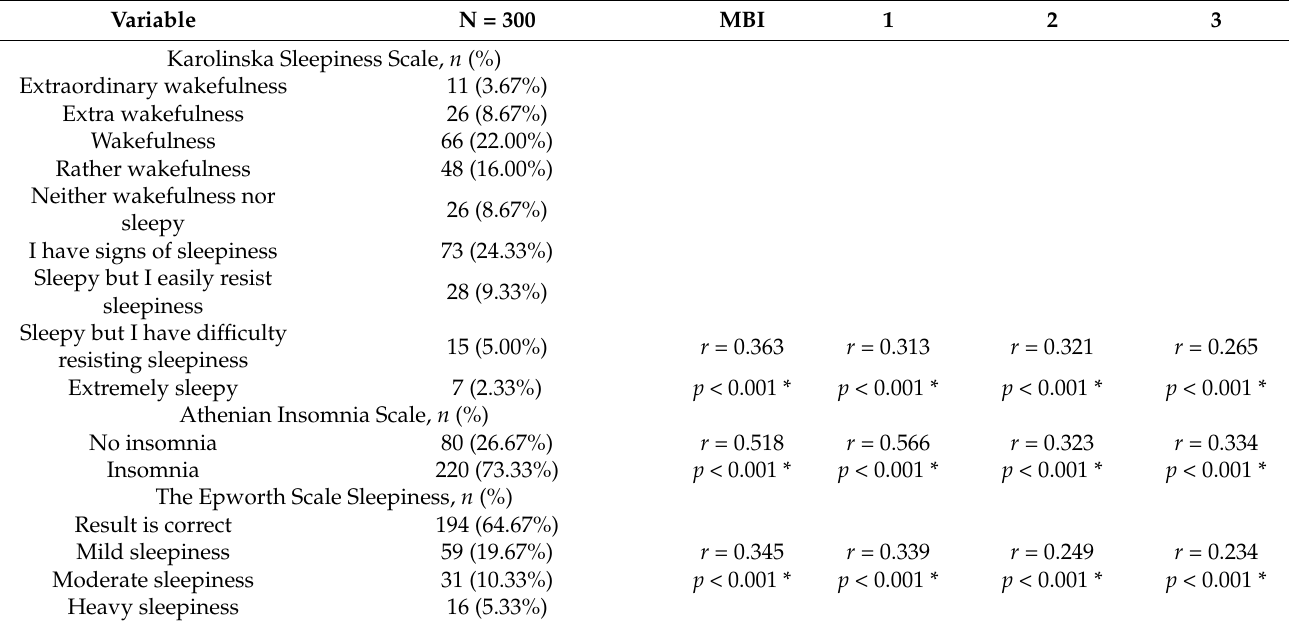
Table 4. The correlations between sleepiness and